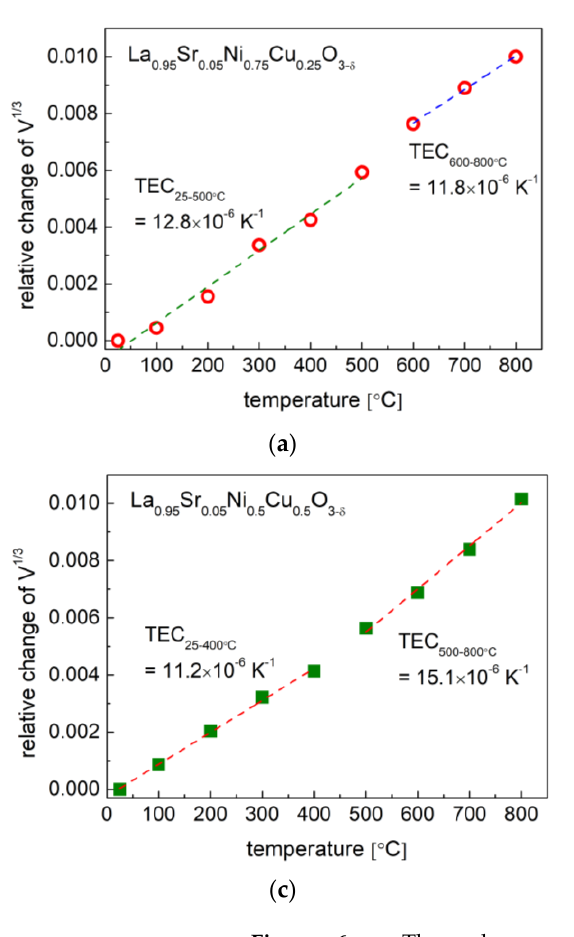
Figure 6. Thermal expansion coefficients calculated from HT-XRD data (V 1/3 ) for ( a )